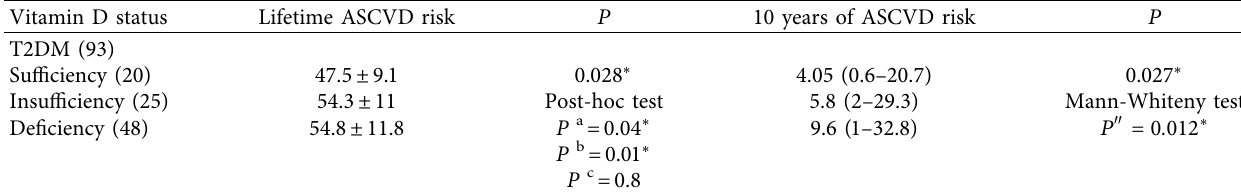
Table 3: Lifetime and 10-year ASCVD risk among type 2 diabetic patients in relation to serum vitamin D levels. Vitamin D status